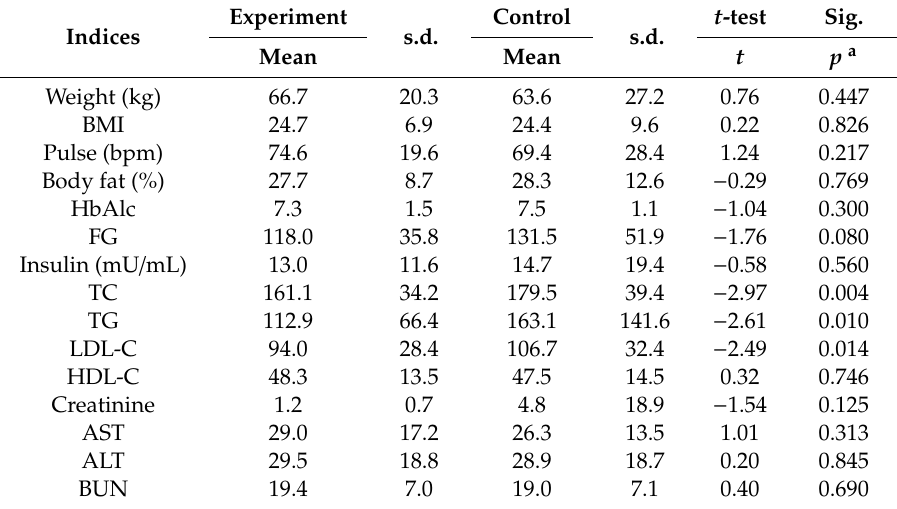
Table 5. Summary of comparisons between experimental and control groups,